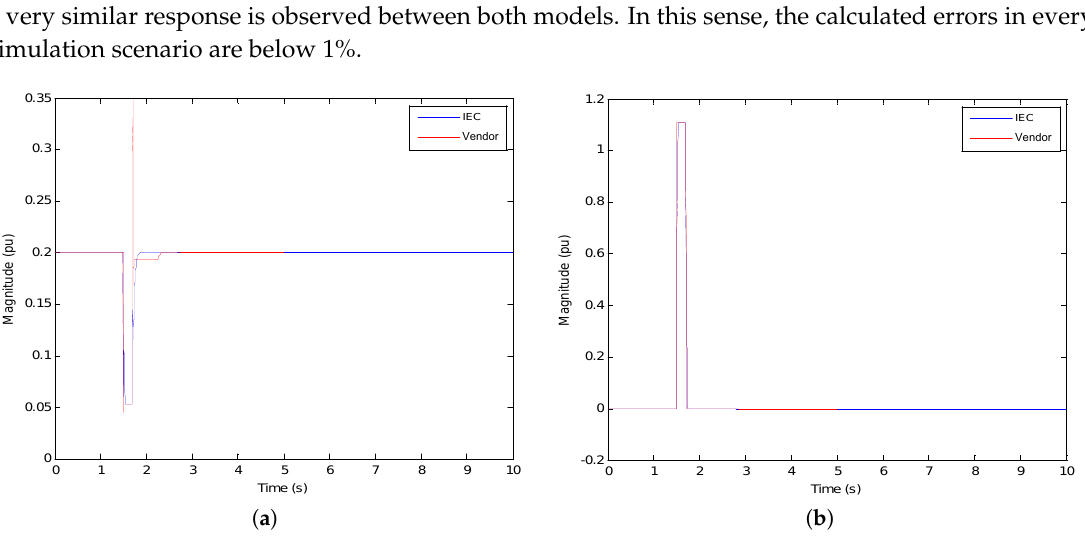
Figure 10. Type IVA results. Simulation scenario: p = 0.20 pu, u = 0.20 pu, t = 200 ms. ( a ) Active power, p ; and ( b ) reactive current, i q